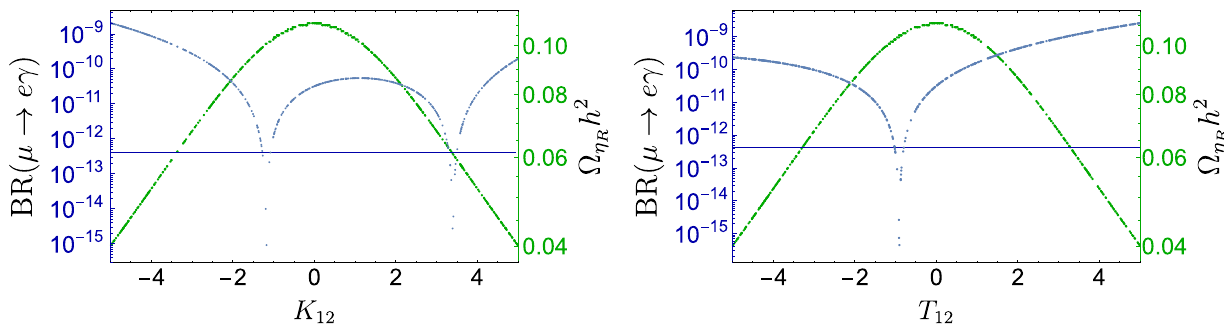
Fig. 4 BR( μ → e γ ) (left vertical axis, blue points) and relic abundance of η R (right vertical axis, green points) as a function of K 12 (left panel) and T 12 (right panel). The horizontal line represents the current upper bound on BR( μ → e γ ) [40]. Therefore, all blue points above this line are excluded Fig. 5 Spin-independent η R -nucleon elastic scattering cross section – weighted by the relative abundance – versus m η . Same color code as in R Fig. 2. The green dashed area is excluded by the most recent upper bound from the XENON1T experiment [45]. The dashed orange curve indicates the expected discovery limit corresponding to the “ ν -floor” from CE ν NS of solar and atmospheric neutrinos for a Ge target [60]. The dashed red curve depicts the projected sensitivity expected at LUX-ZEPLIN (LZ) [61]